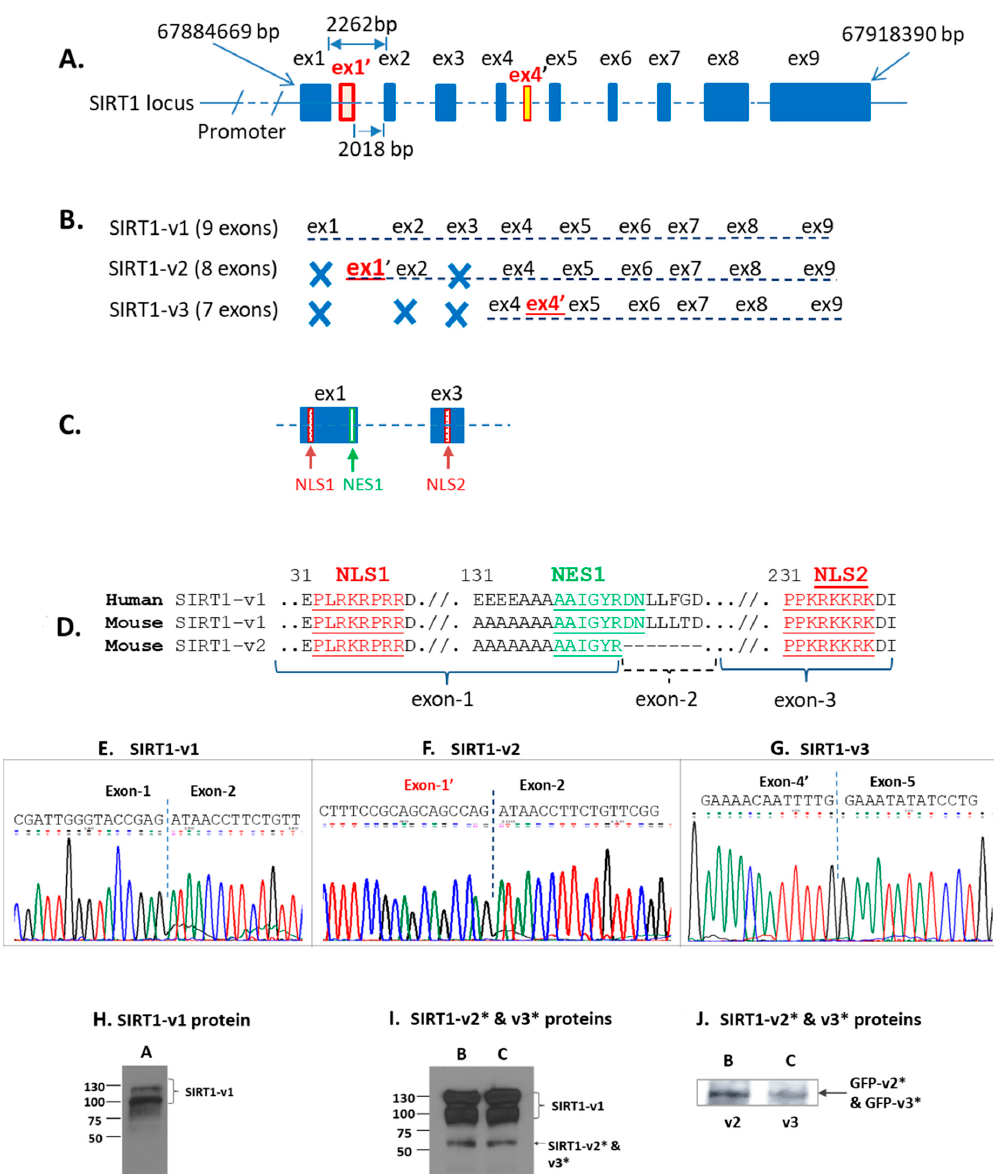
Figure 3. Bioinformatic and experimental analysis of human SIRT1-v1, v2, and v3 isoforms. ( A ). SIRT1 gene locus and genomic DNA landscape. ( B ). SIRT1-v1 isoform contained nine exons, whereas SIRT1-v2 contained eight exons, in which the first exon had not been previously reported and it was named exon-1 ′ (ex1 ′ ), SIRT1-v3 isoform contained seven exons. The Exon-4 ′ (ex4 ′ ) was immediately behind exon-4 and it had not been previously reported. ( C ). Exon-1 (ex1) and exon-3 (ex3) contained nuclear localization signal sequences. ( D ). Sequence analysis of human SIRT1-v1 in comparison with both mouse SIRT1-v1 and v2. During alternative splicing, mouse SIRT1-v2 lost exon-2, but retained exon-1 and exon-3 that have NLS. Therefore, both mouse SIRT1-v1 and v2 isoforms are likely to be localized in the nucleus. ( E – G ). The sequencing chromatogram image of exon-junctions that were observed in SIRT1-v1 (Figure 3E), SIRT1-v2 (Figure 3F), and SIRT1-v3 (Figure 3G). ( H – J ). SIRT1 isoform protein expression in cell lysate samples that were transfected with plasmid constructs SIRT1-v1 ( A ), SIRT1-v2 ( B ), and SIRT1-v3 ( C ). ( I ). SIRT1-v2 and v3 protein expression. ( J ). GFP-SIRT1-v2 and –v3 fusion proteins were detected by anti-GFP antibody. * The molecular weight of SIRT1-v2 is 50.5 kDa, and SIRT1-v3 is 49.25 kDa,